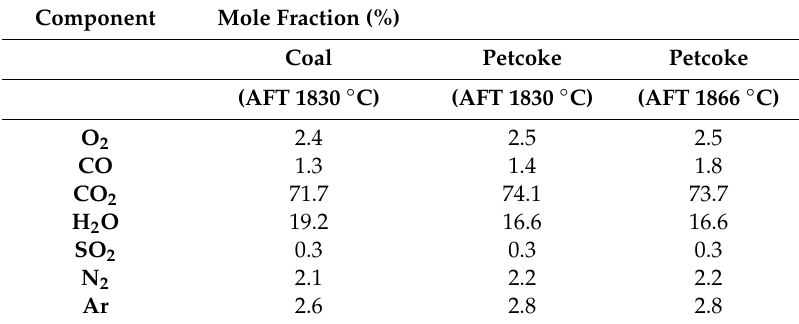
Table 4. Composition of the flue gas stream after combustion (HOT-PROD in Figure 2) for oxy-coal and oxy-petcoke combustion.